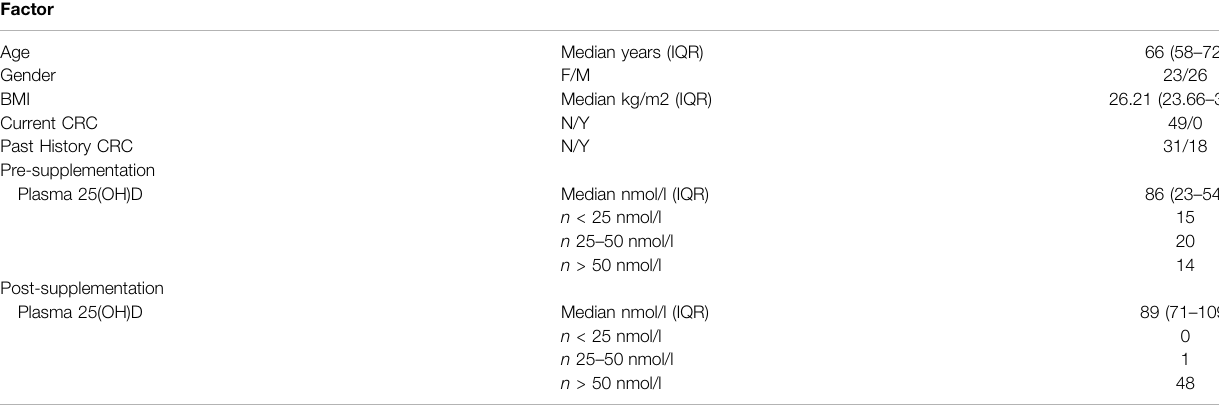
TABLE 1 | Demographic and clinical information of SCOVID study